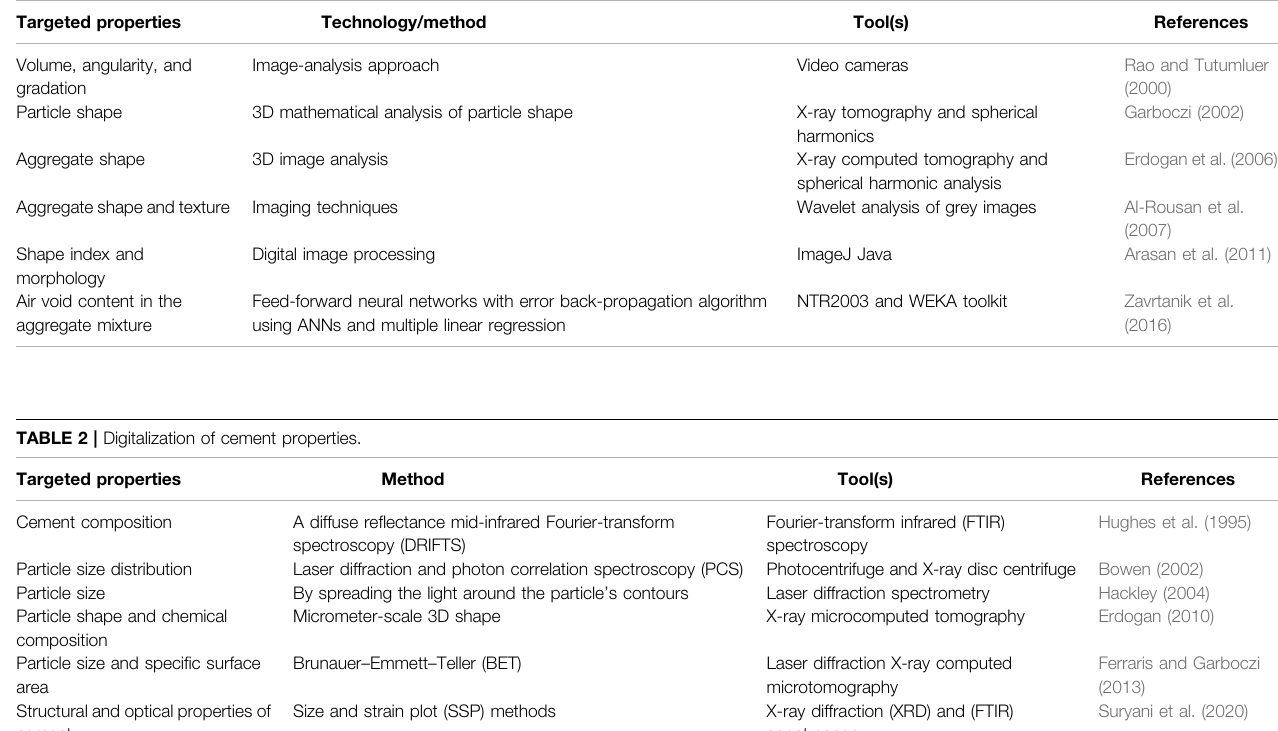
TABLE 1 | Digitalization of aggregate properties.